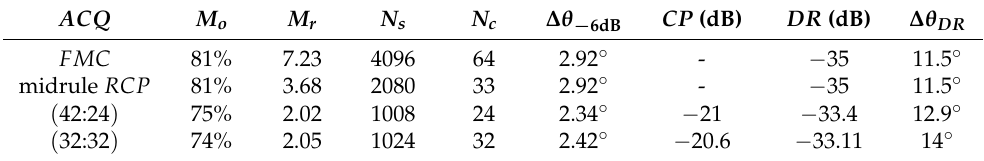
Table 3. Spiral array: FMC , RCP , ACQ ( 42:24 ) and ACQ ( 32:32 ) acquisition strategies